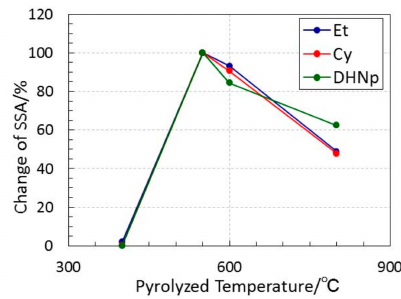
Figure 7. Relative specific surface areas (SSAs) evaluated for ROSZ-derived amorphous Si–O–N samples as a function of pyrolysis temperature.